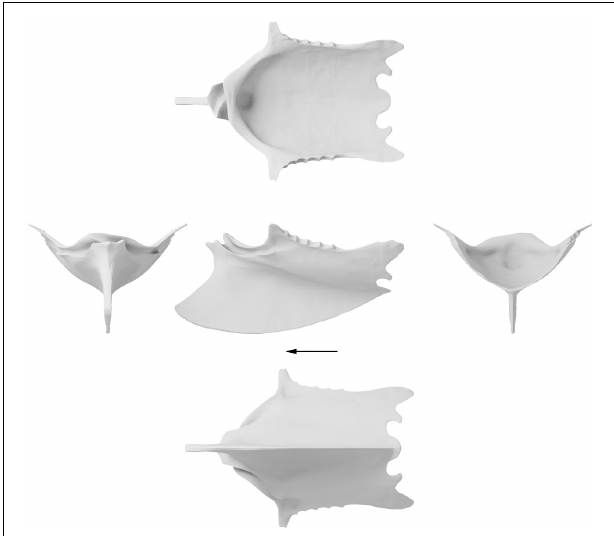
FIGURE 5 | Surface approximation of a retrodeformed Ichthyornis dispar sternum. Left, cranial view; middle, dorsal, lateral and ventral view; right, caudal view. Arrow indicates cranial